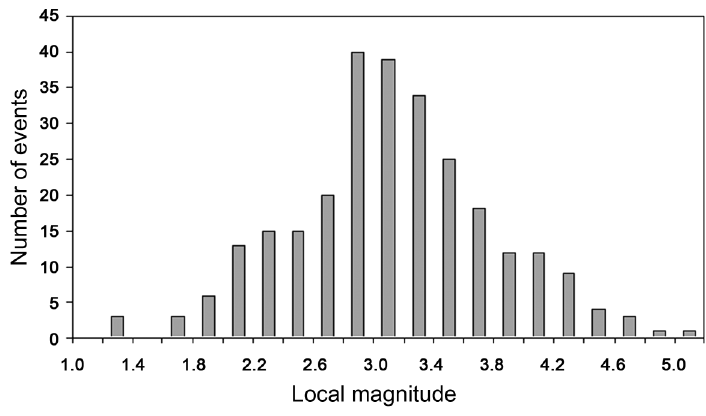
Fig. 2. Distribution of local magnitudes for earthquakes within 100 km of Maltese islands, 1995-present.